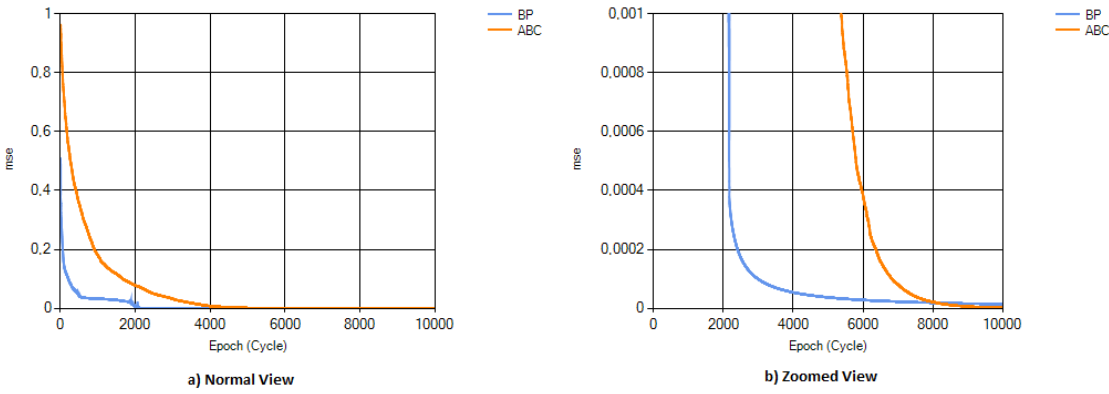
Figure 5. ANN-Backpropagation (BP) and ANN-ABC mean squared error (mse)